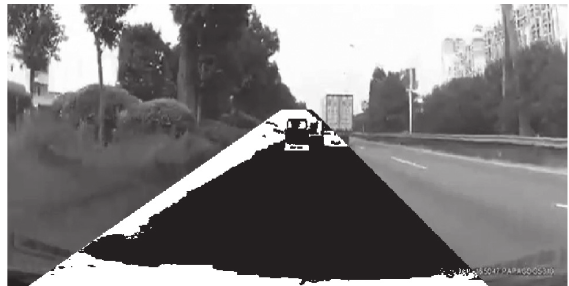
Figure 4: Vehicle shadow binary image.